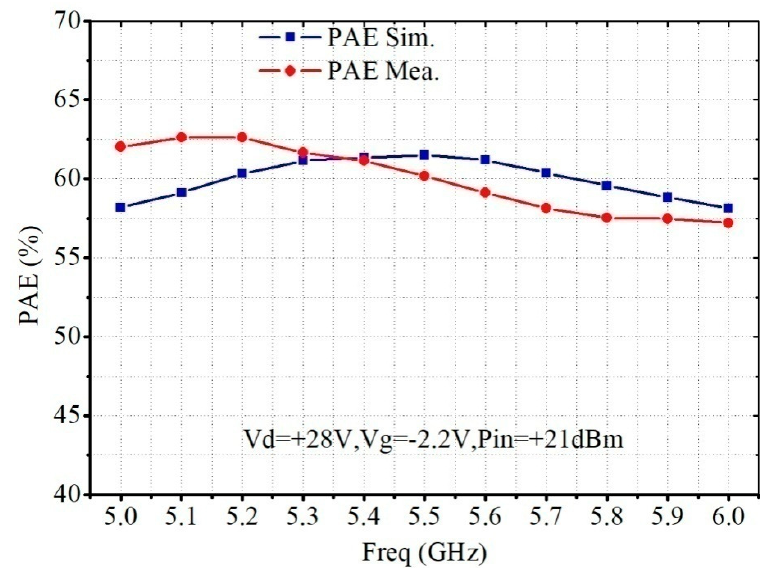
Figure 9. Simulated and measured PAE of the proposed C-band 30 W PA MMIC.